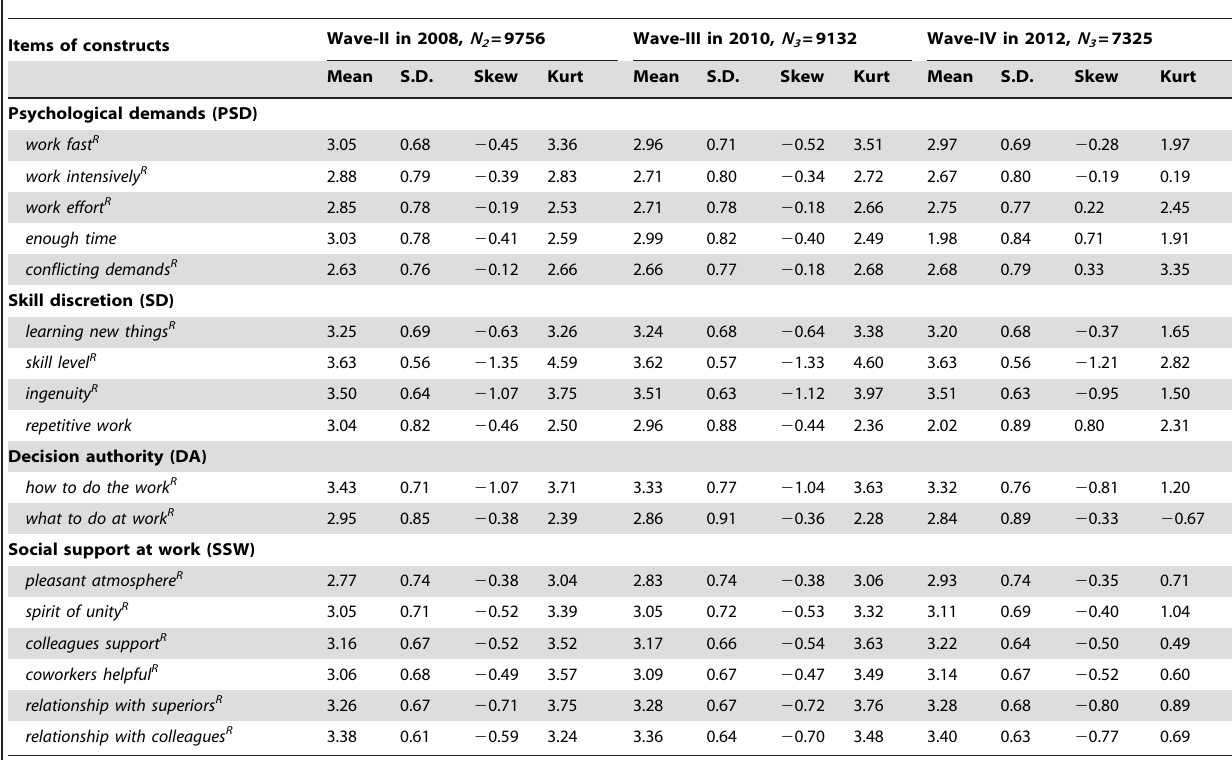
Table 1. Distributions of the items of Demand-Control-Support scale over 3 waves.